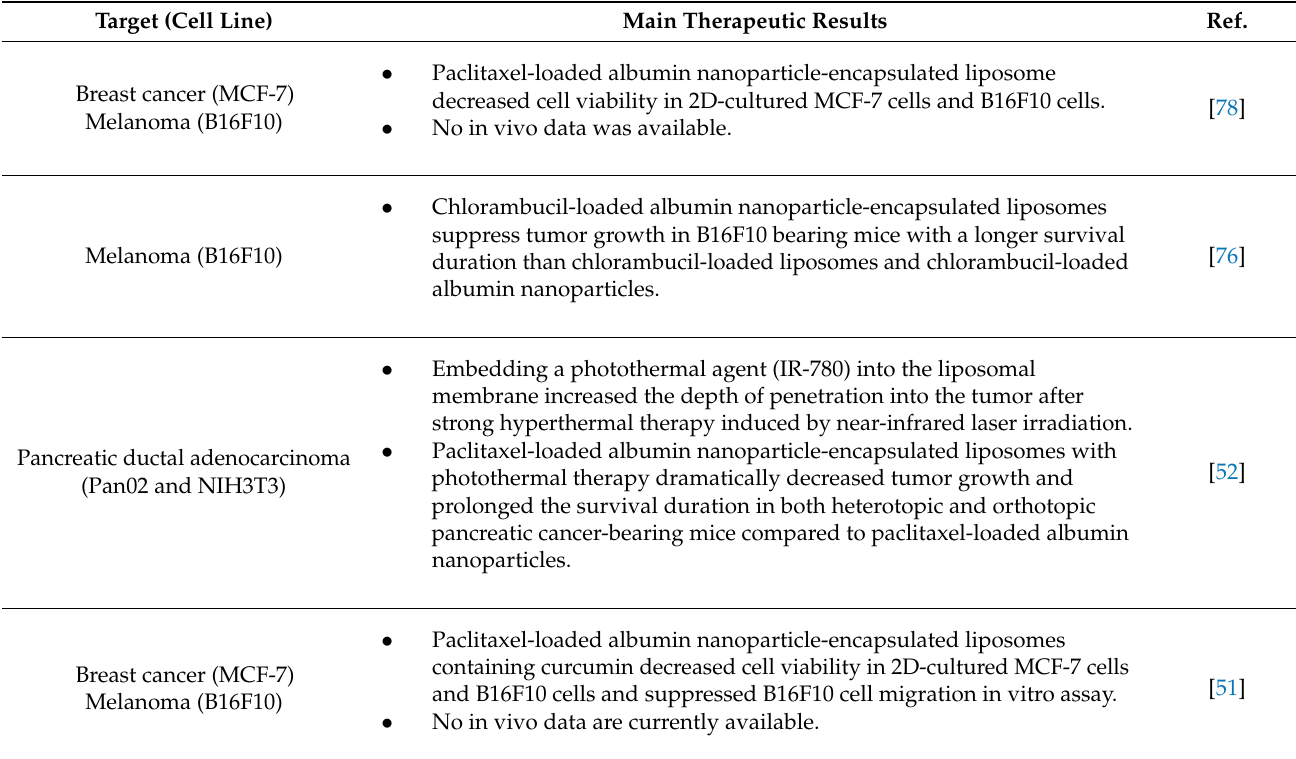
Table 1. List of therapeutic benefits of albumin-encapsulated liposomes for biomedical application. Target (Cell Line) Main Therapeutic Results